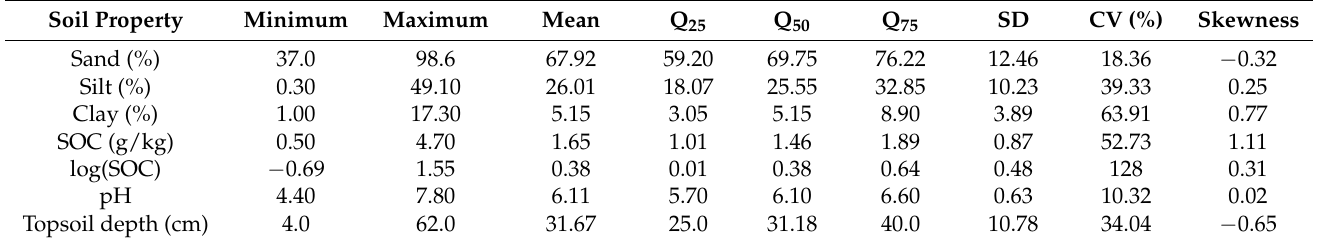
Table 2. Descriptive statistical summary of soil properties in the study area. Qi: i-th percentile; SD: standard deviation; CV: coefficient of variation.